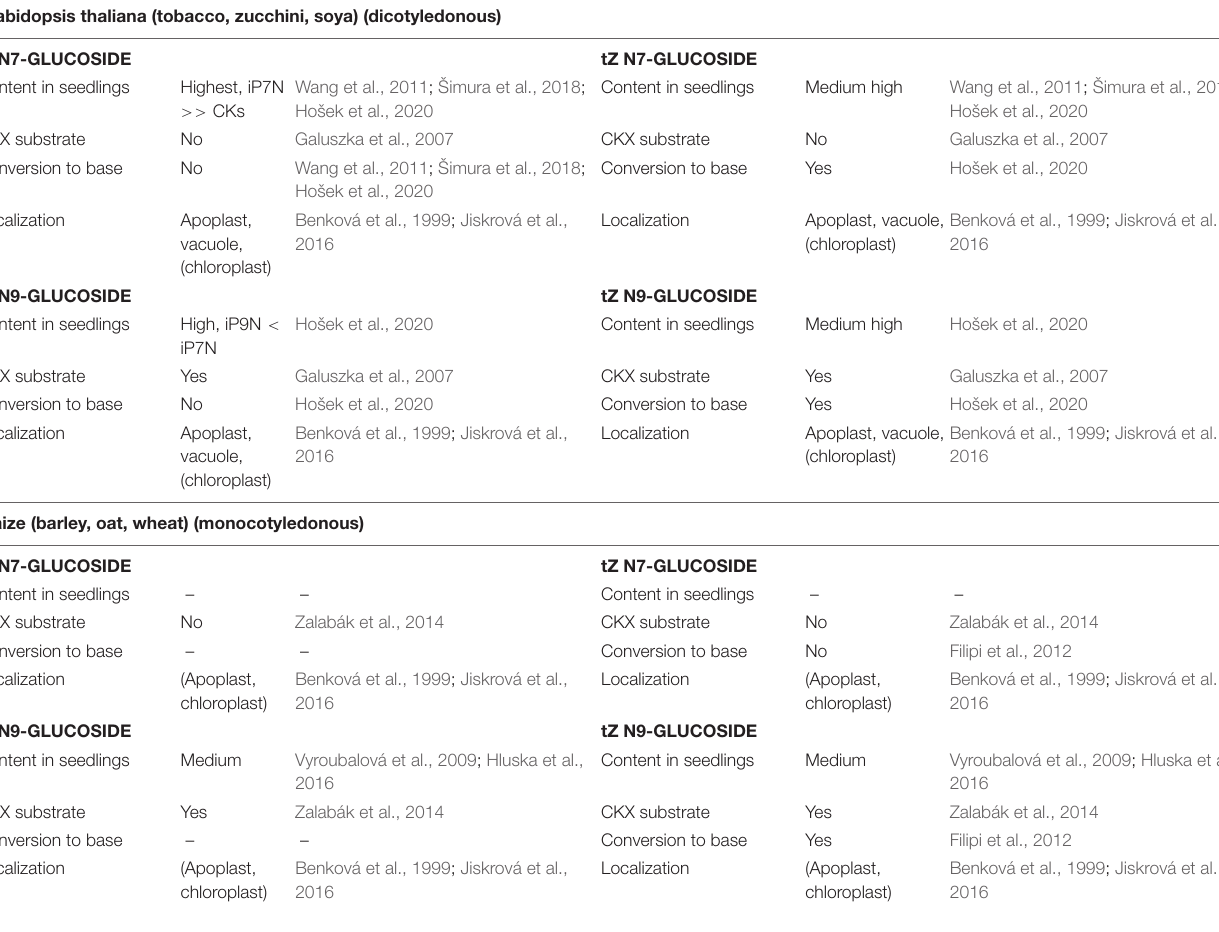
TABLE 1 | Isopentenyladenine (iP) and trans -zeatin (tZ) N7- and N9-glucosides characteristics observed in dicotyledonous and monocotyledonous plants. Arabidopsis thaliana (tobacco, zucchini, soya) (dicotyledonous) iP N7-GLUCOSIDE tZ